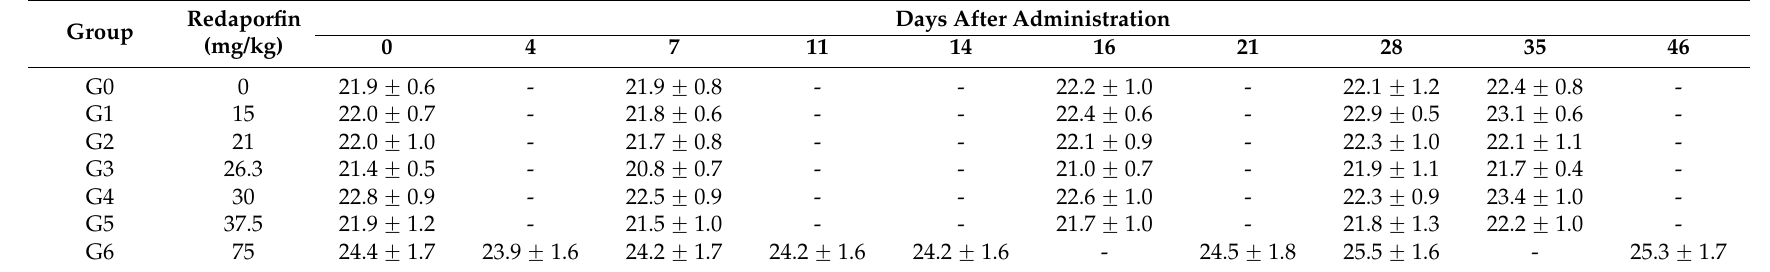
Table 1. Mice body weight (g) over time after the i.v. injection of redaporfin formulation for each study group (average ˘ SD).